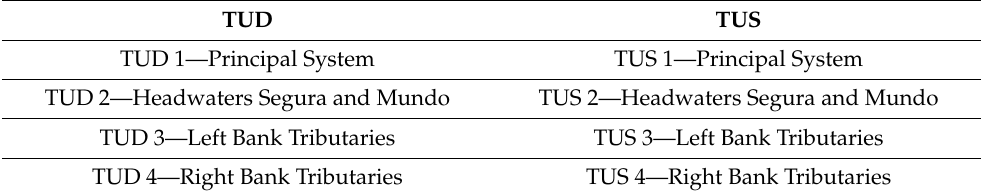
Table 6. Relationship between TUD and TUS. Source: SDP 2018